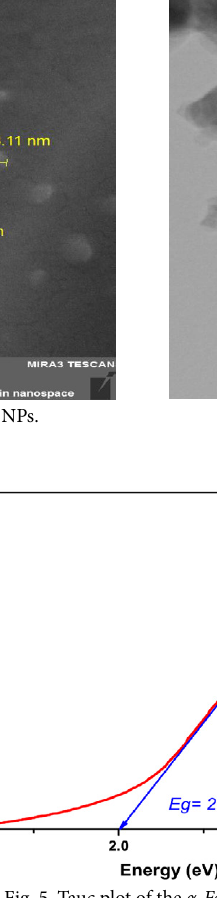
Fig. 5. Tauc plot of the α -Fe 2 O 3 NPs